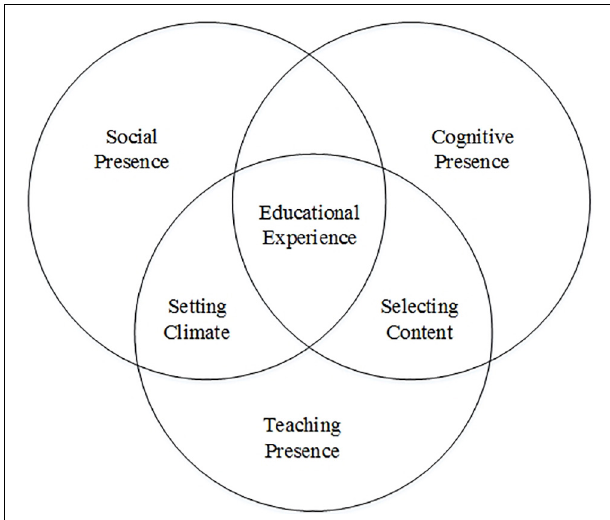
FIGURE 1 | The community of inquiry (Law et al.,